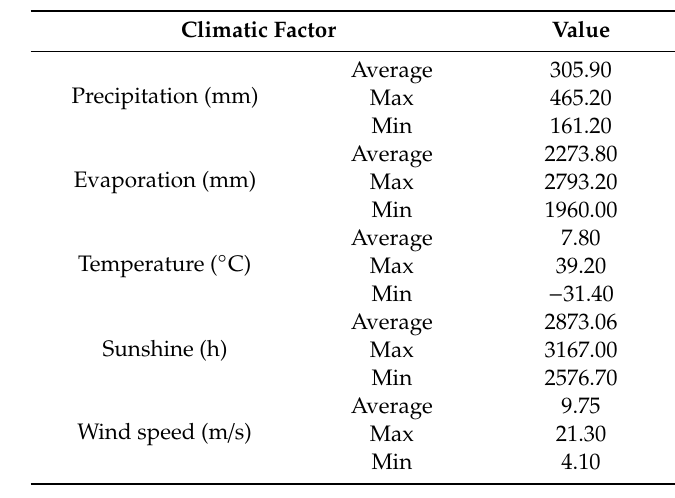
Meteorological information in the UPABC (Urban Planning Area of Baotou City). The meteorological information comes from Baotou meteorological observatory (40 ◦ 40 (cid:48) N, 109 ◦ 51 (cid:48) E, altitude: 1005.9 m